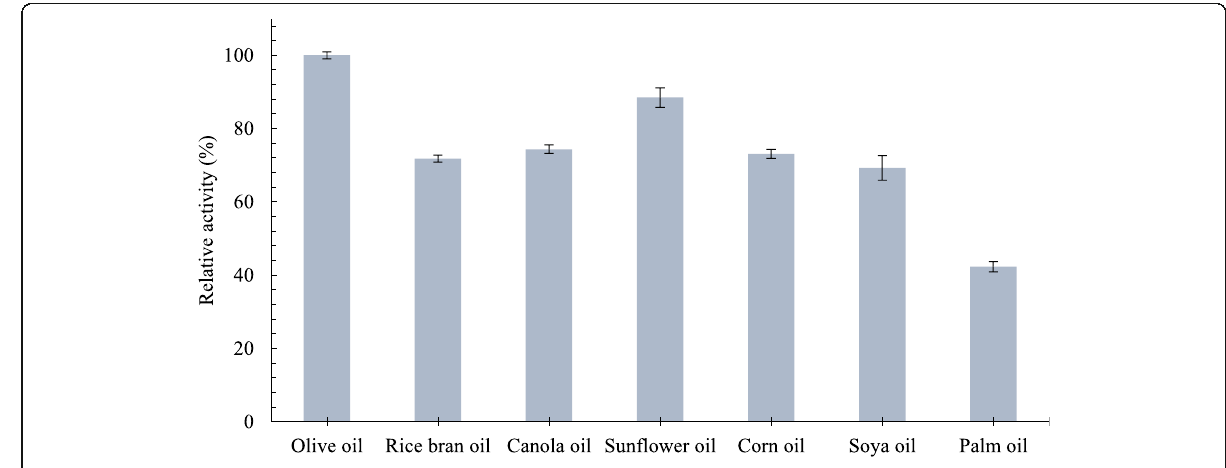
Fig. 6 Comparison of hydrolysis capability by LipEMP48-D on various long-chain